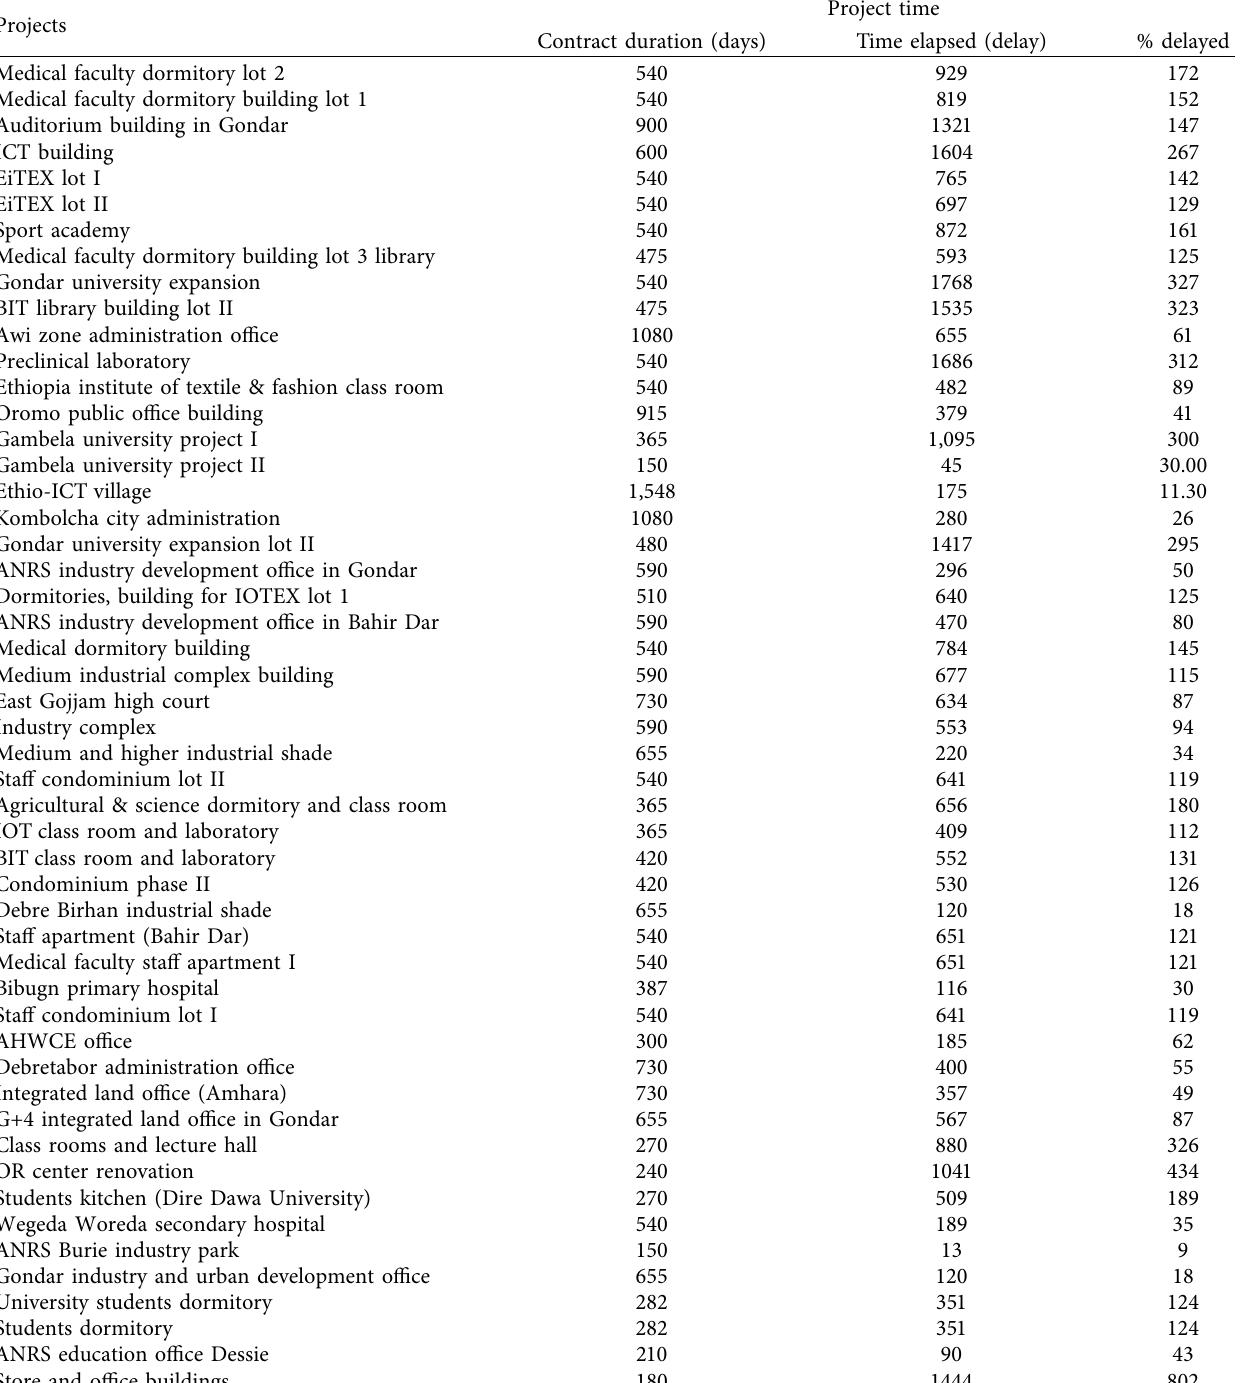
Table 5: Time data for building construction